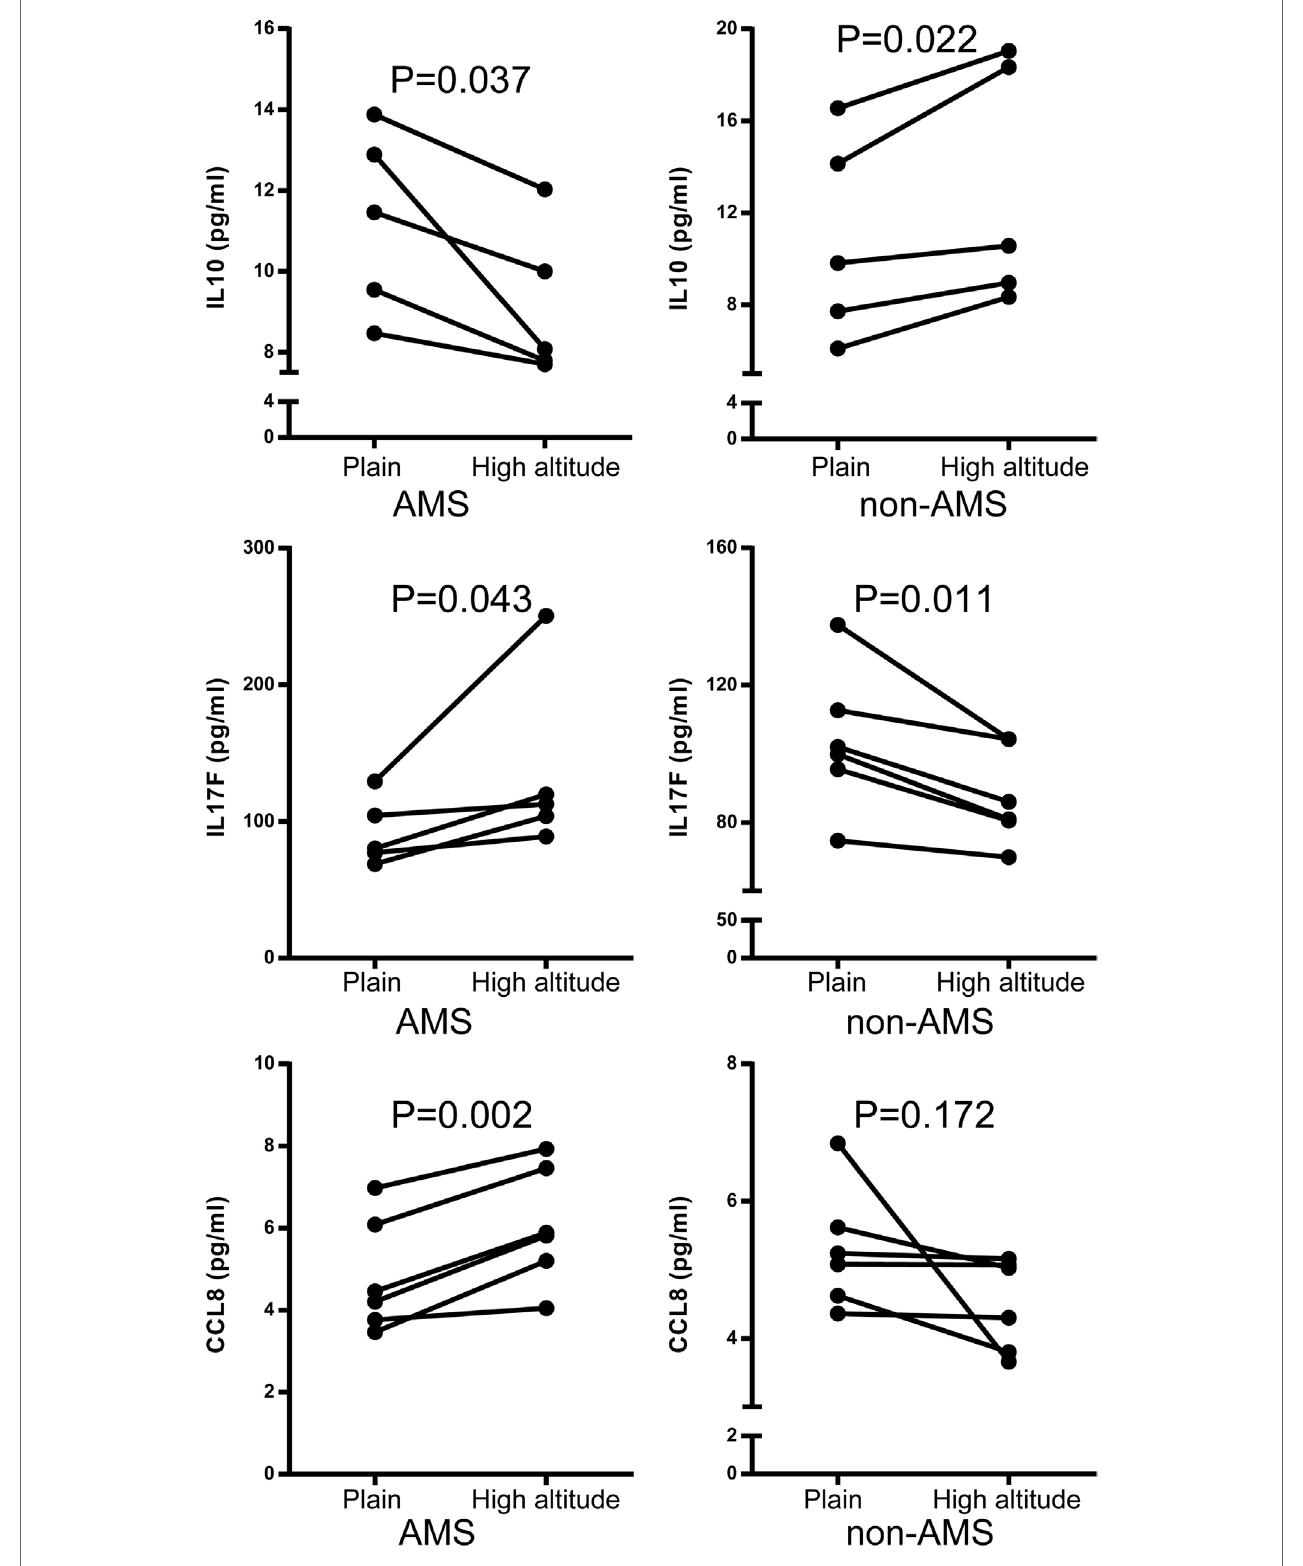
FigUre 4 | Quantification of il10, il17F, and ccl8 protein using enzyme-linked immunosorbent assay acute mountain sickness (aMs) ( N = 5) and non-aMs ( N = 5) individuals in transcriptome assay set before and after exposure to high altitude, respectively